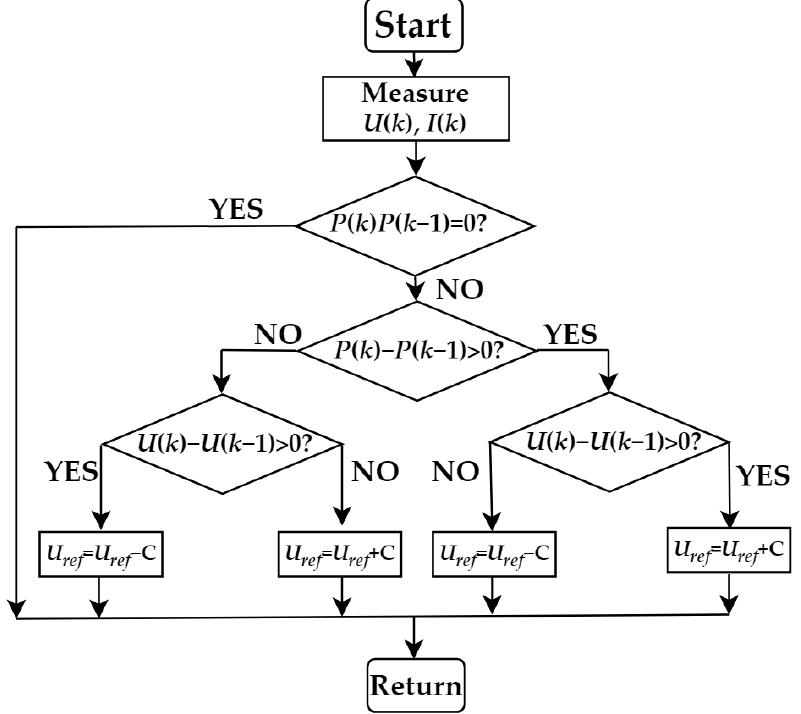
Figure 3. A control flow chart of the disturbance observation method.